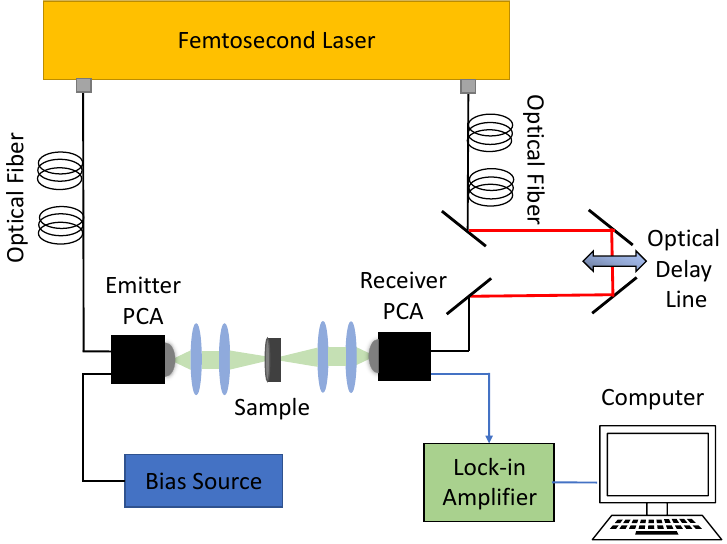
Figure 1. A schematic of the experimental